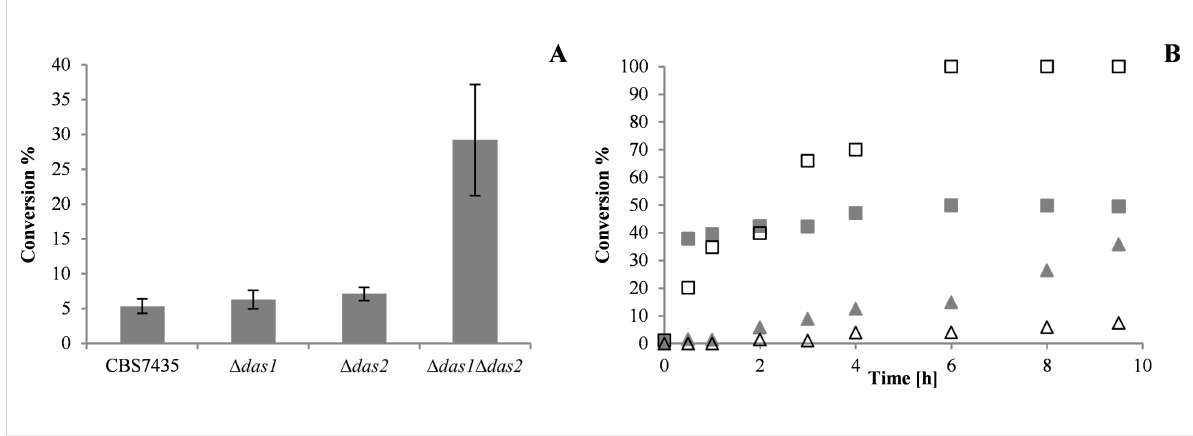
Figure 4: BDH1-based whole-cell conversions of rac -acetoin. (A) Conversions of 25 mM rac -acetoin in the different knock-out strains were performed in 96 well deep-well plates for 16 h. The shown conversions represent mean values ± standard deviations derived from reactions using whole cells from 40 individual BDH1 transformants. (B) Time-resolved biotransformations of 50 mM substrate were conducted in the wild type (grey squares) and in the Δ das1 Δ das2 strain background (white squares). Background activity by endogenous acetoin reducing enzymes of P. pastoris was observed (grey triangles: P. pastoris CSB7435 wild type, white triangles: P. pastoris Δ das1 Δ das2